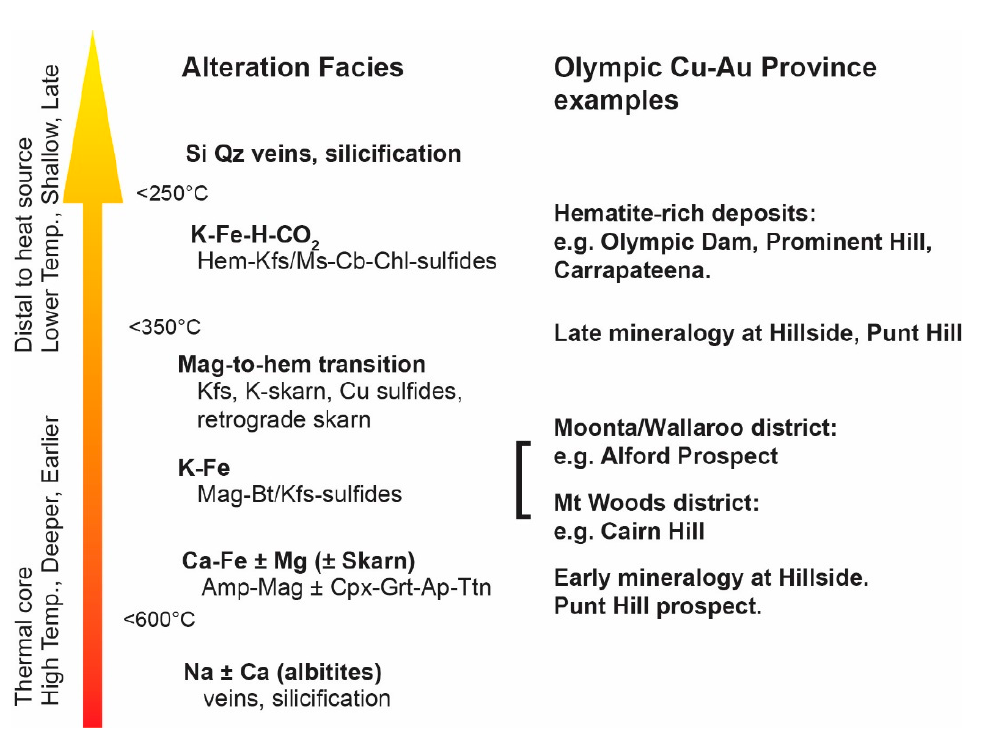
Figure 10. Iron oxide-copper-gold (IOCG) alteration facies model modified from Corriveau, et al. [19], with examples of deposits and prospects from the Olympic Cu-Au Province that preserve similar alteration facies. This model systematizes the alteration mineral assemblages that form across the range of temperatures that produce IOCG systems. While some systems may evolve through the full temperature spectrum, other systems may preserve only high or low temperature portions of